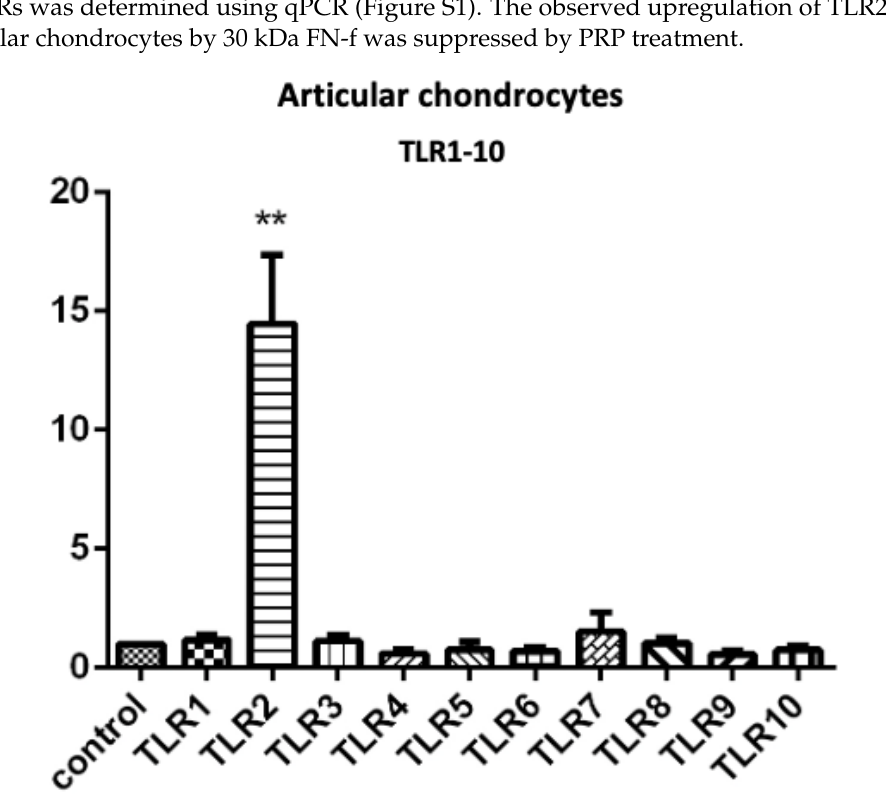
Figure 1. Gene expression of TLR1-10 induced by 30 kDa FN-f in articular chondrocytes. Significant upregulation of the TLR2 gene was observed in human articular chondrocytes (** p < 0.001; FN-f treatment compared without FN-f treatment control; n = 3, respectively). The other TLR types treated with FN-f showed no significant changes compared to without FN-f treatment control; n = 3, respectively. All data are presented as the mean ± SD. Statistical differences among the TLR groups were compared with control values using the Student’s t -test.